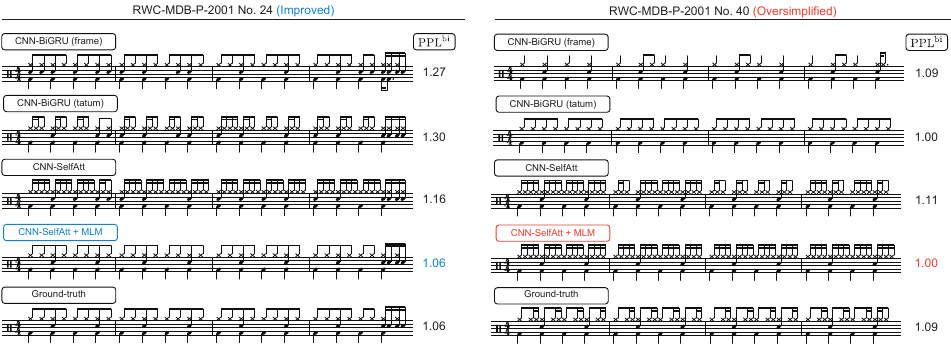
Figure 10. Examples of improved ( left ) and oversimplified ( right ) drum scores estimated by CNN- SelfAtt-SyncPE with the MLM-SyncPE-based